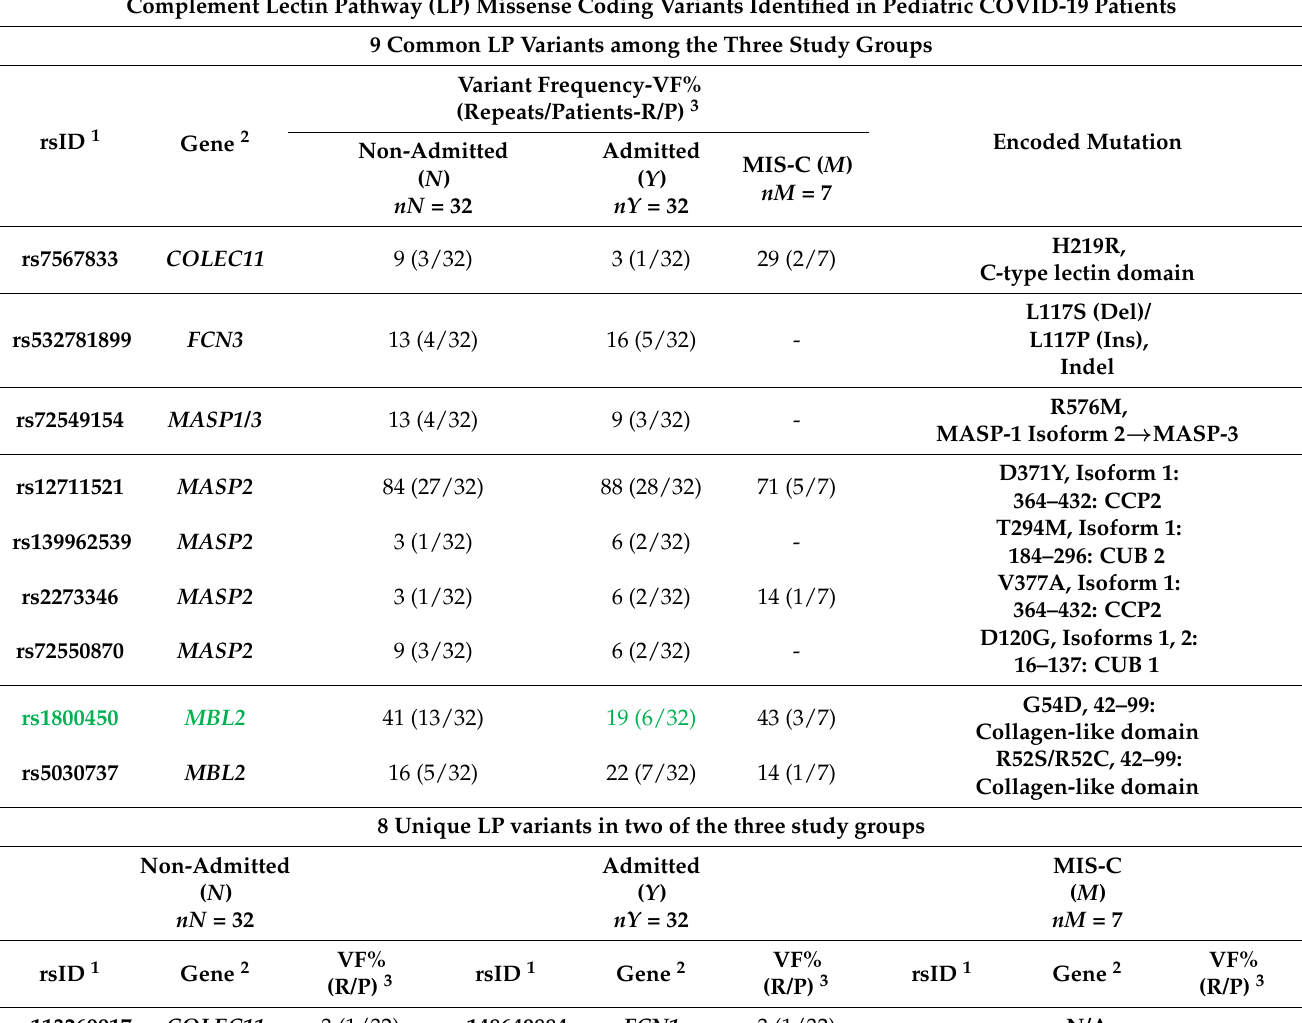
Table 3. The human lectin pathway (LP) associated complement missense coding SNPs detected in pediatric COVID-19